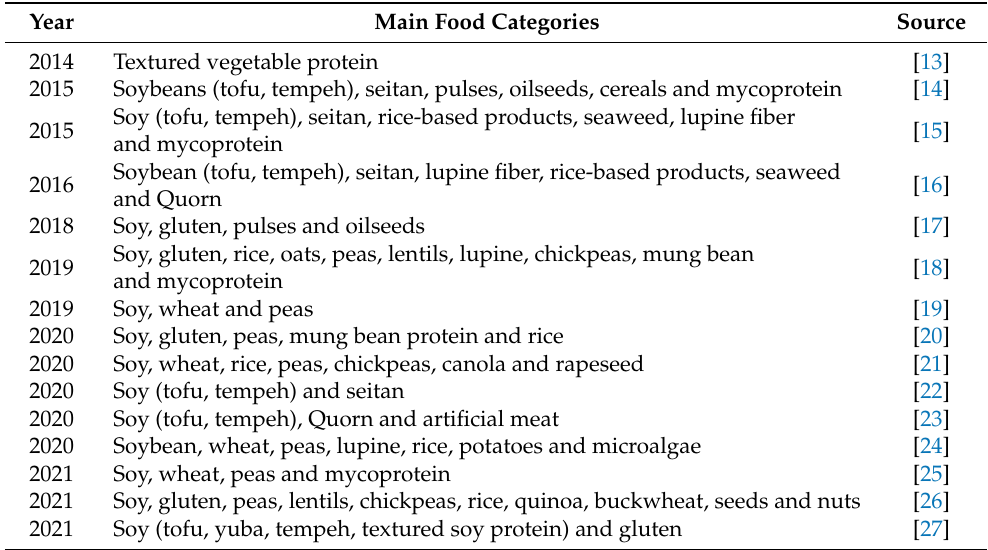
Table 1. Main categories of alternative products to animal origin,